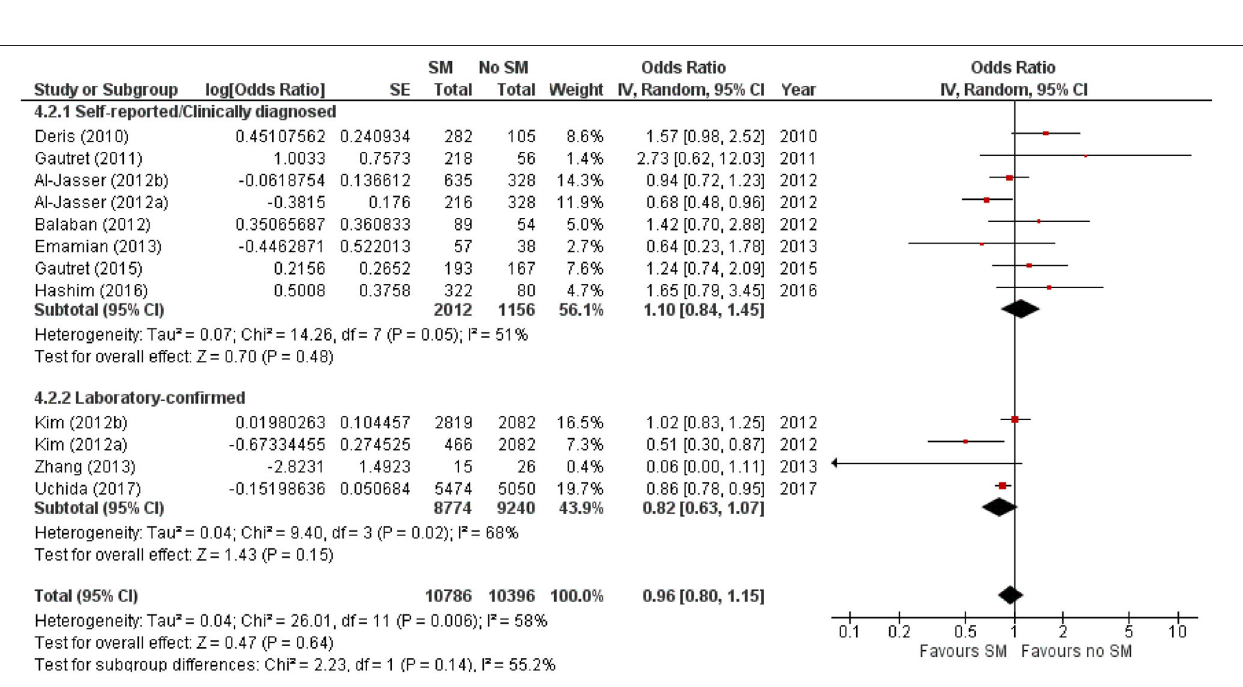
FIGURE 3 | Subgroup analysis of ARI incidence when surgical masks were worn compared with not wearing surgical masks, according to outcome ascertainment methods, estimated with the generic inverse method and a random-effects model. SM, surgical face mask; No SM, no surgical face mask; OR, odds ratio.